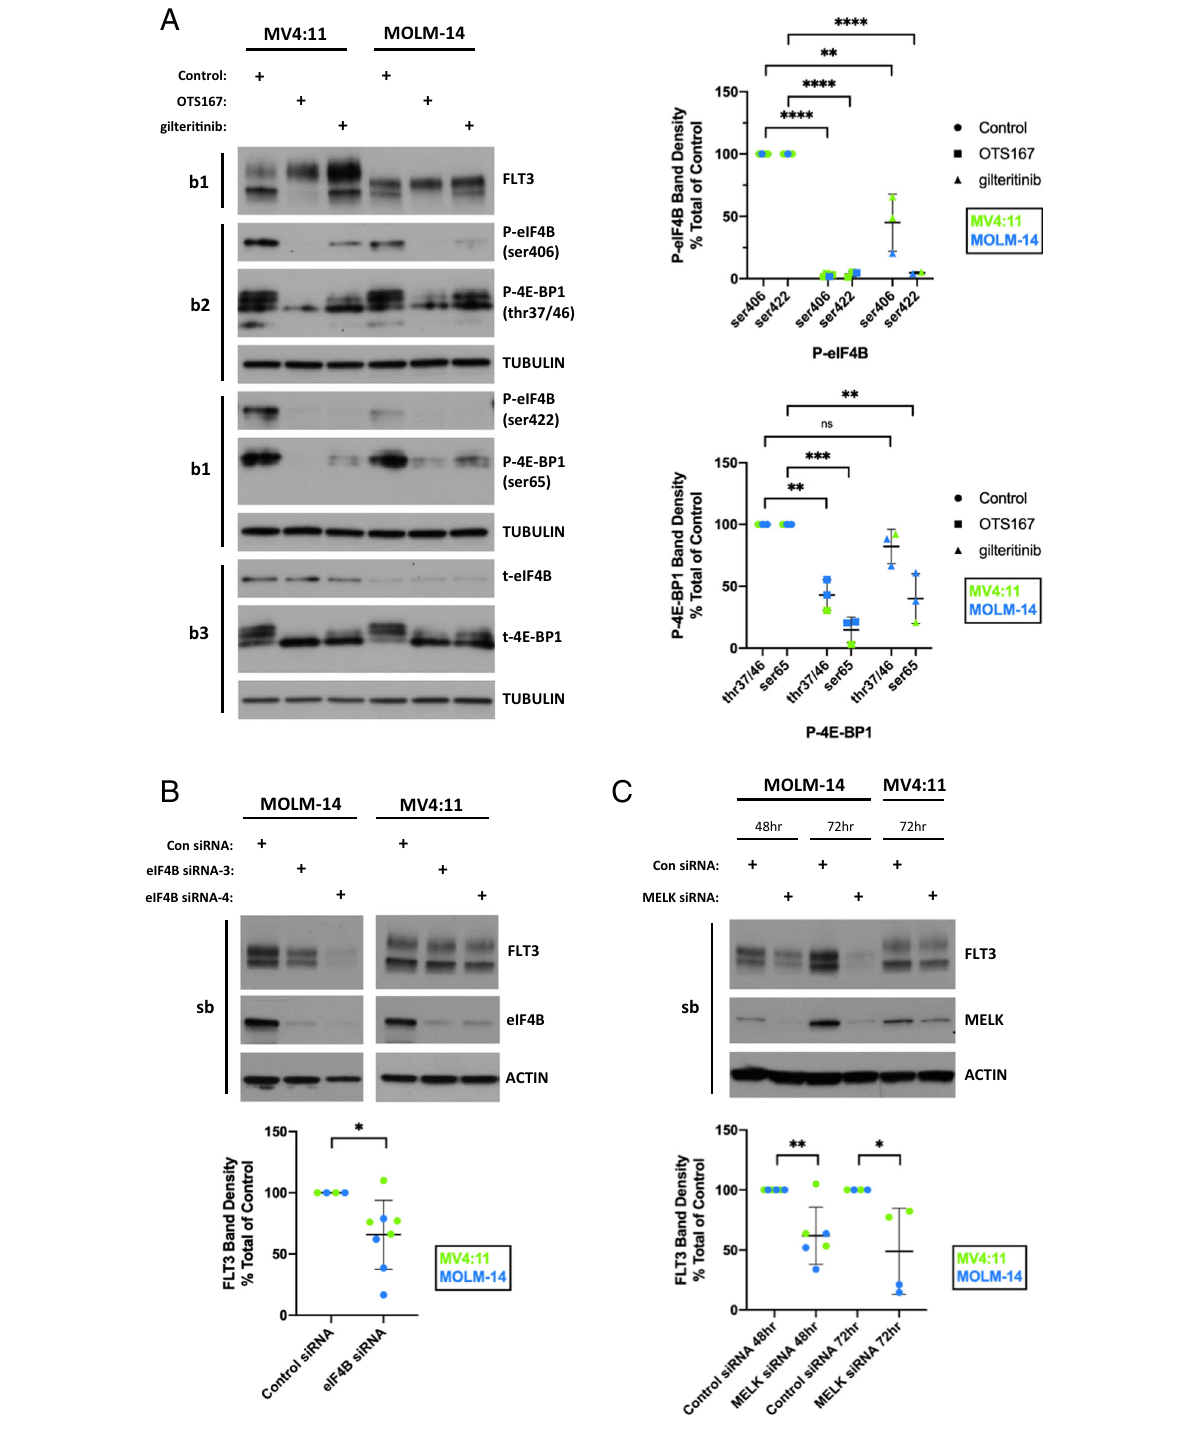
Fig. 3 (See legend on next